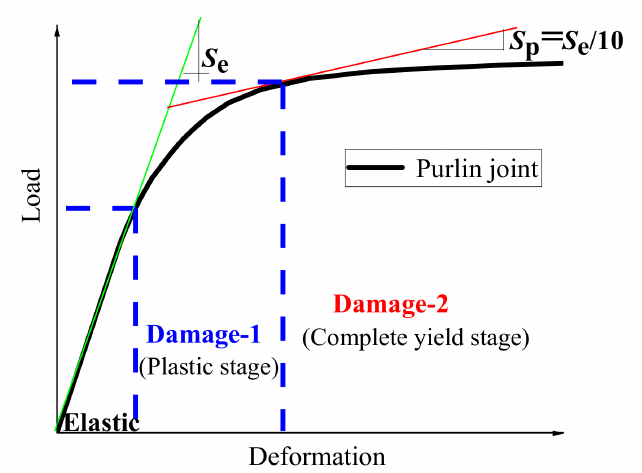
Figure 9. Damage stage divisions of a purlin joint.